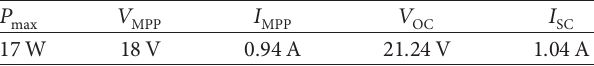
Figure 16: Experimental comparison of INC and FOINC and VFOINC with EVSS (variable irradiance). Table 1: Specification of SYK17-18M solar